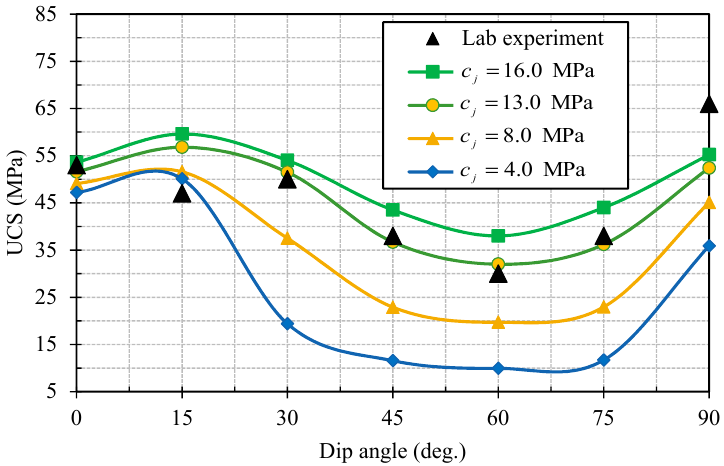
Figure 21. Strength variation of transversely isotropic rock samples with different bonded joint cohesion.